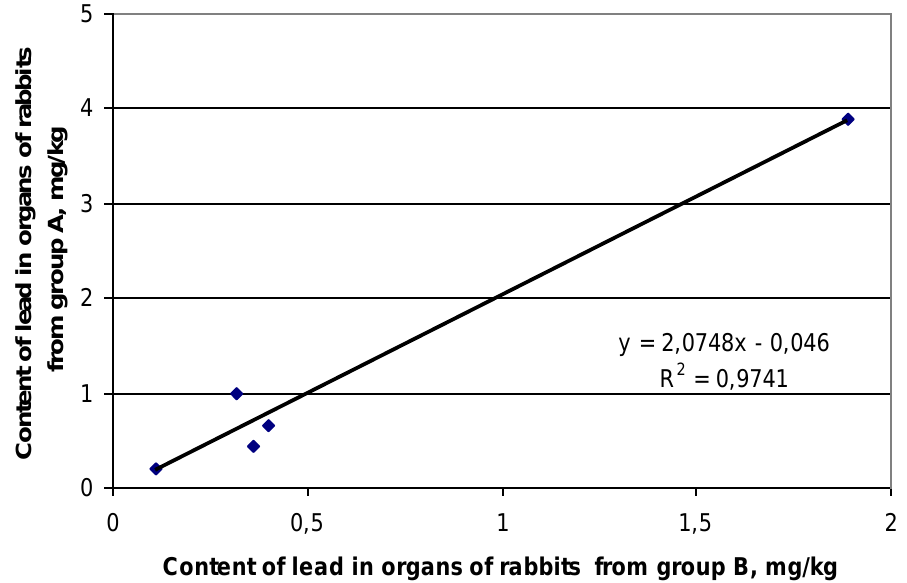
FIGURE 2. Relationship between the content of Pb in the organs of the rabbits from group A and group